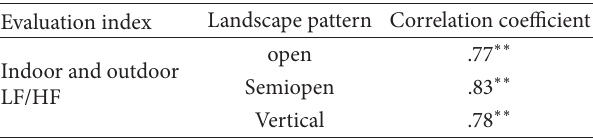
Table 7: Correlation analysis of the evaluation indices in each scenario.